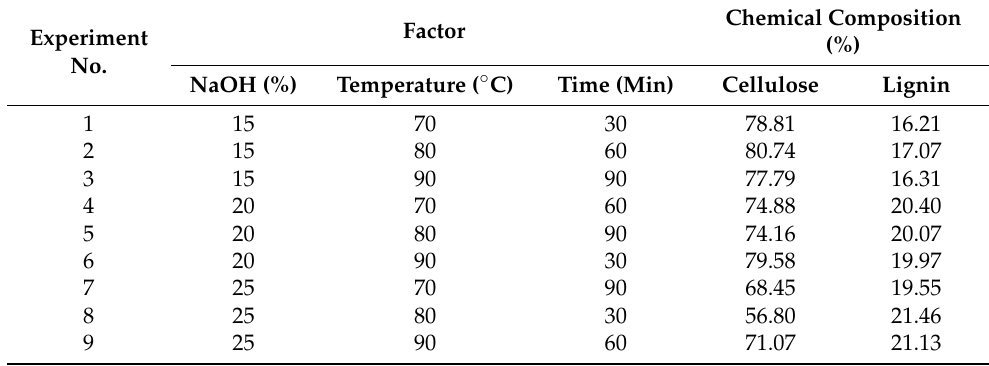
Table 2. Factor levels in the experimental design for the optimization of alkaline extraction.